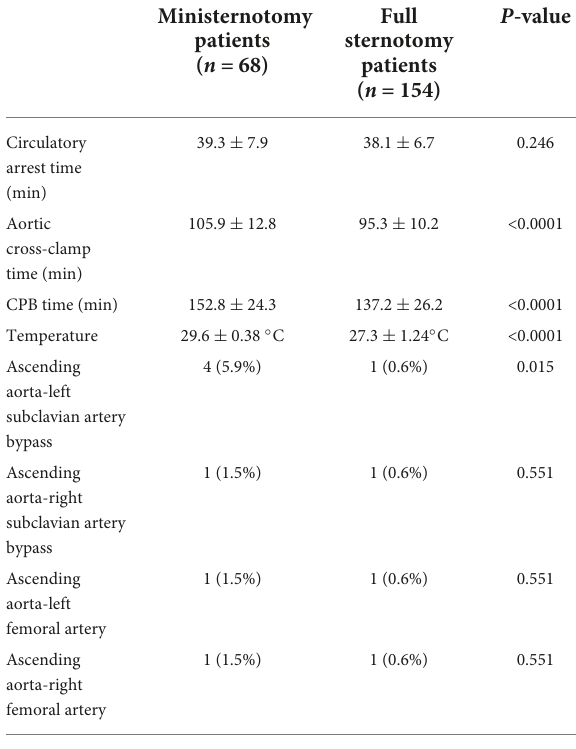
TABLE 2 Intraoperative